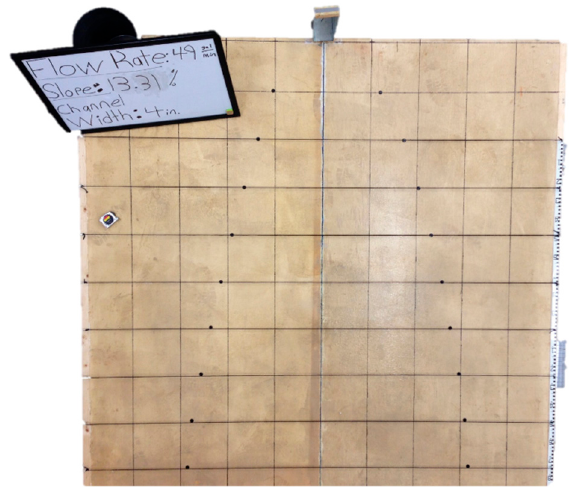
Figure 2. The physical test apparatus for measuring the area of water spread from a 10.2 cm (4 in.) discharge width onto a platform, in this case with a roughened painted surface. Grid lines are at 25-cm spacing in both directions. The black dots are pennies placed by hand to mark the greatest extent of wetting observed during the run.